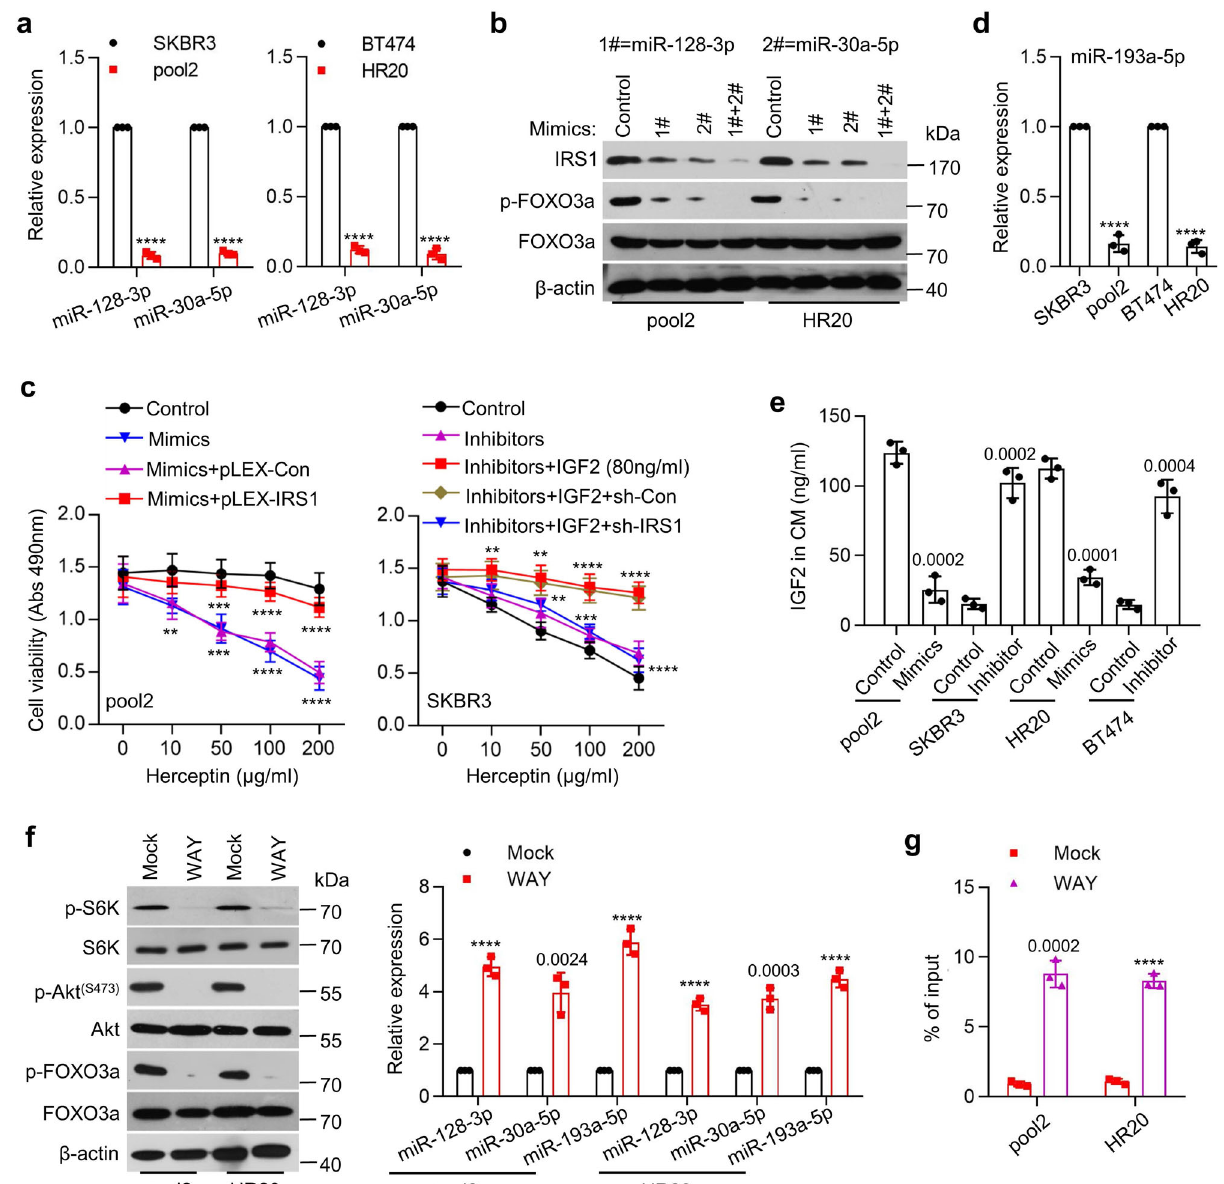
Fig. 5 Dysregulation of FOXO3a-miRNAs axis conferred Herceptin resistance. a The expression levels of miR-128-3p and miR-30a-5p in SKBR3, pool2, BT474, or HR20 cells were measured by qRT-PCR, **** p < 0.0001. b Pool2 or HR20 cells were transfected with miR-128-3p or/and miR-30a-5p mimics. The expression of IRS1, p-FOXO3a, FOXO3a, and β -actin was examined by western blot assays. c Pool2 cells were transfected with miRNA mimics in combination with pLEX-IRS1 followed by Herceptin treatment at indicated concentrations for 72 h (left). SKBR3 cells were transfected miRNA inhibitors in combination with IRS1 shRNA, and then treated with 80 ng/ml rhIGF2 along with Herceptin (right). Cell viability was evaluated by MTS assays. Pool2 Mimics: ** p = 0.0022, *** p = 0.0003, **** p < 0.0001, Mimics + pLEX-IRS1: *** p = 0.0001, **** p < 0.0001, SKBR3 Inhibitors + IGF2: ** p = 0.0072, ** p = 0.0035, **** p < 0.0001, Inhibitors + IGF2 + sh-IRS1: ** p = 0.0079, *** p = 0.0002, **** p < 0.0001. d The expression levels of miR-193a-5p in SKBR3, pool2, BT474, and HR20 cells were detected by qRT-PCR, **** p < 0.0001. e Pool2 or HR20 cells were transfected with a miR- 193a-5p mimic. SKBR3 or BT474 were transfected with a miR-193a-5p inhibitor. IGF2 levels in the CM were measured by ELISA. f Pool2 or HR20 cells were treated with vehicle (Mock) or WAY-600 (1 μ M, WAY). The expression of p-Akt (S473) , Akt, p-S6K, S6K, p-FOXO3a, FOXO3a, and β -actin was examined by western blot assays (left); the expression levels of miR-128-3p, miR-30a-5p and miR-193a-5p were detected by qRT-PCR (right), **** p < 0.0001. g Pool2 or HR20 cells were treated with WAY-600 for 24 h. The enrichment of FOXO3a at miR-193a-5p promoter was examined by ChIP- qPCR assays, **** p < 0.0001. n = 3 biological independent samples ( a , c – e , g ). Data are presented as mean values ± SEM ( a , c – e , g ). Statistical signi fi cance was determined by a two-tailed Student ’ s t -test ( a , c – e , g ). Data show a representative of three independent experiments ( b , f ). All data are provided in the Source